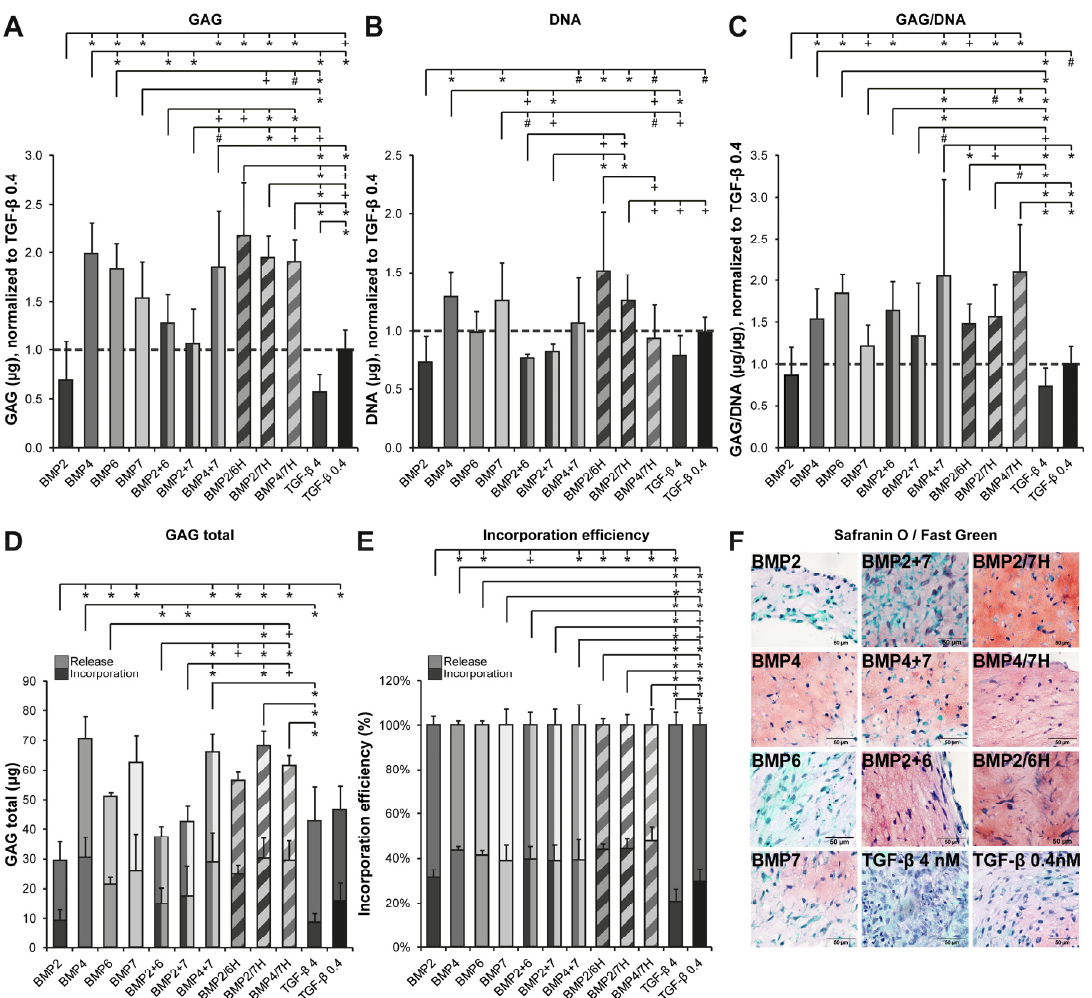
Figure 1. Glycosaminoglycan (GAG) production by human degenerated nucleus pulposus (NP) cells from 4 donors cultured on filters coated with type II collagen and treated with di ff erent bone morphogenetic proteins (BMPs, 4 nM total concentration, also with combinations of homodimers and heterodimers (H)) and compared to transforming growth factor (TGF)- β 1 controls (4 and 0.4 nM, equal to 100 and 10 ng / mL). GAG and DNA content, GAG / DNA are displayed relative to 0.4 nM TGF- β 1-treated NP cells, which were set at 1 (indicated by the dashed line). All the data are n = 12 (3 separate repetitions per donor per condition). ( A ) GAG content was highest in di ff erentiation cultures with BMP4 and BMP2 / 6H and lowest for 4 nM TGF- β 1 and BMP2. ( B ) DNA content was highest when cells were cultured with BMP2 / 6H, BMP4, BMP2 / 7H, and BMP7. ( C ) The amount of GAG corrected for DNA was highest in BMP4 / 7H, followed by BMP4 + 7, BMP6, and BMP4. ( D ) Total GAG production, including the GAGs released into the medium and contained in the neotissue, was highest in BMP4, BMP2 / 7H, and BMP4 + 7. ( E ) Incorporation e ffi ciency was highest in the cells cultured with BMP4 / 7H. ( F ) Safranin O / Fast Green staining on histological sections of the NP cells cultured on transwell filters reveals that GAGs were deposited in the presence of all BMPs, although the staining was less intense for BMP2, BMP6, or BMP7. Cells in the presence of controls with 0.4 and especially 4 nM TGF- β 1 produced hypercellular tissues with limited extracellular matrix (ECM). Representative images for all donors are shown. Significant di ff erences are indicated as follows: * p ≤ 0.001, + p ≤ 0.005, # p ≤ 0.01, ˆ p ≤ 0.025, $ p ≤